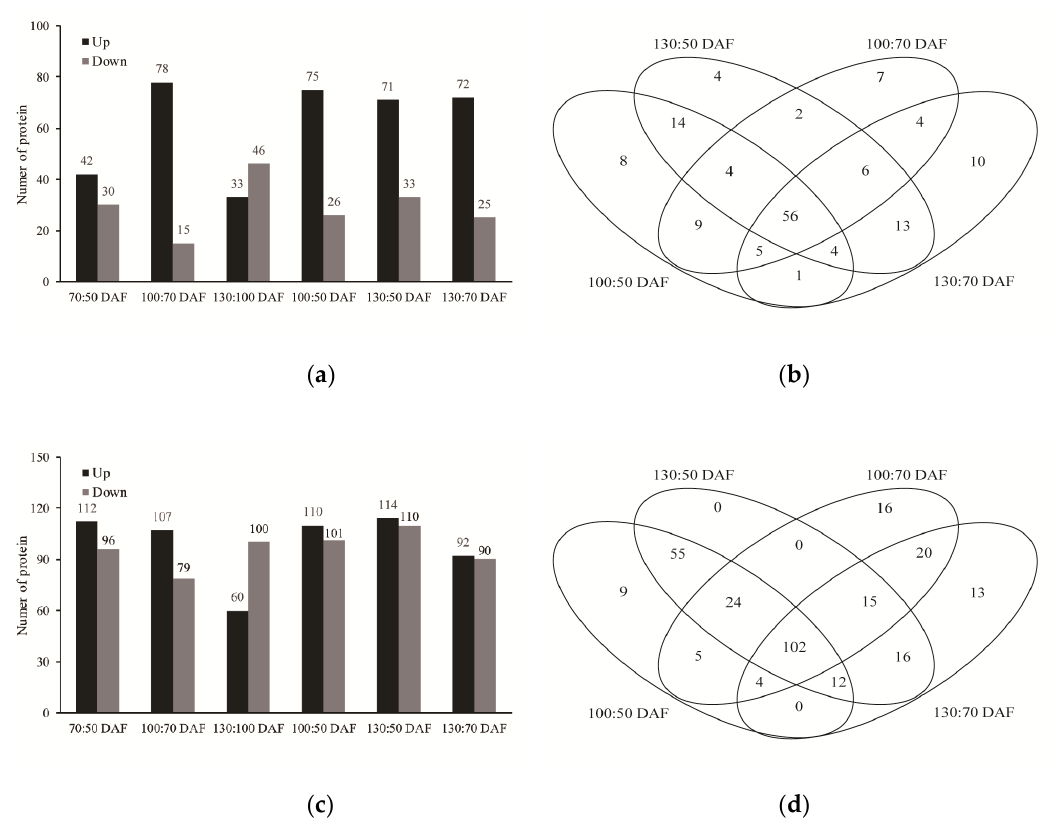
Figure 4. Statistical analysis of differential metabolites (DMs) during developing S. tonkinensis kernels. ( a ) The number of up-regulated and down-regulated DMs in the GC-MS analysis. ( b ) The distribution of DEPs at different time points in the GC-MS analysis. ( c ) The number of up-regulated and down-regulated DMs in the LC-MS analysis. ( d ) The distribution of DEPs at different time points in the LC-MS analysis.